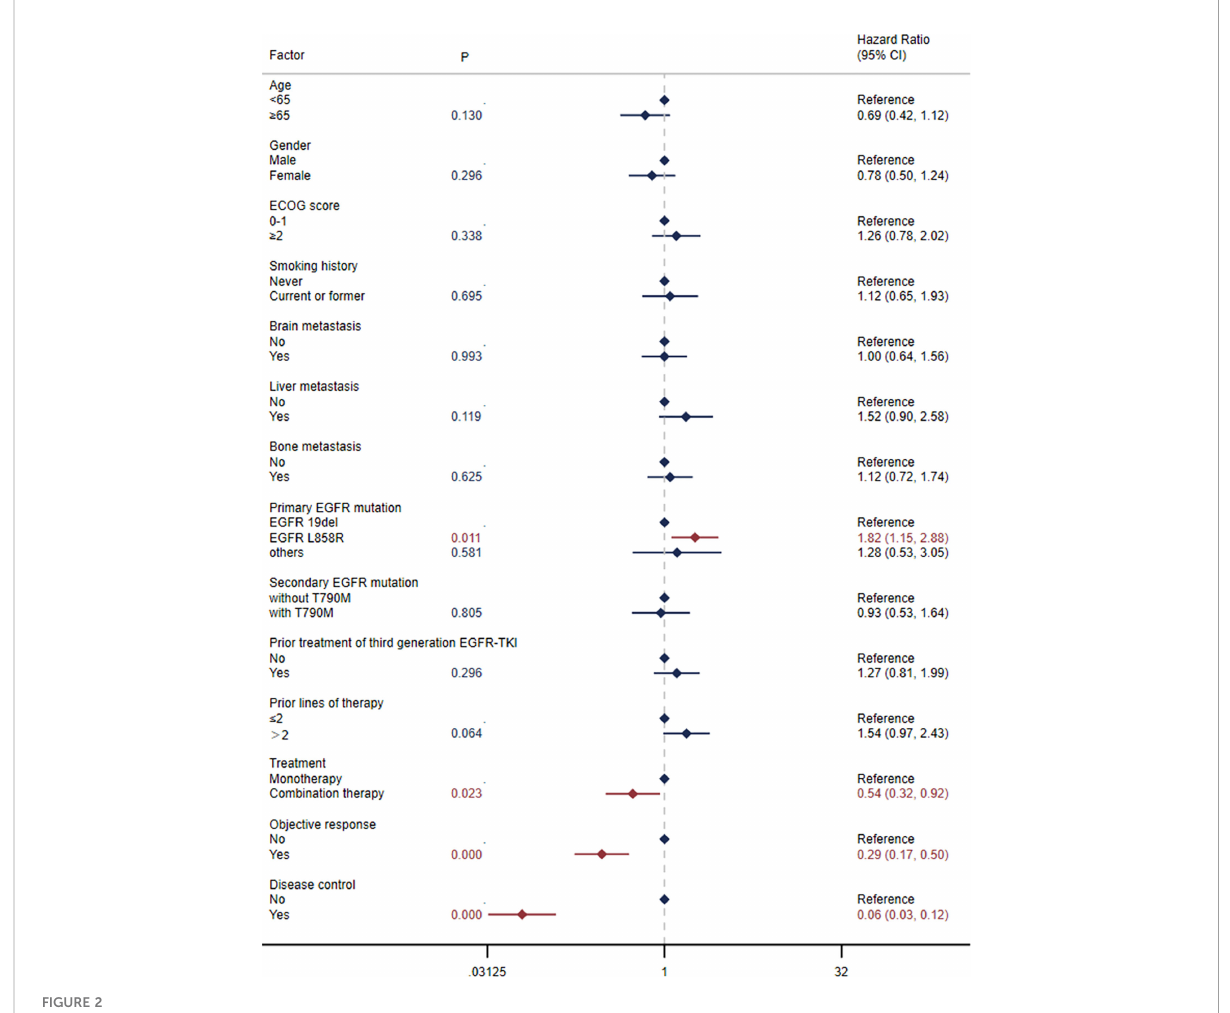
FIGURE 2 Univariate Cox regression analysis for progression-free survival